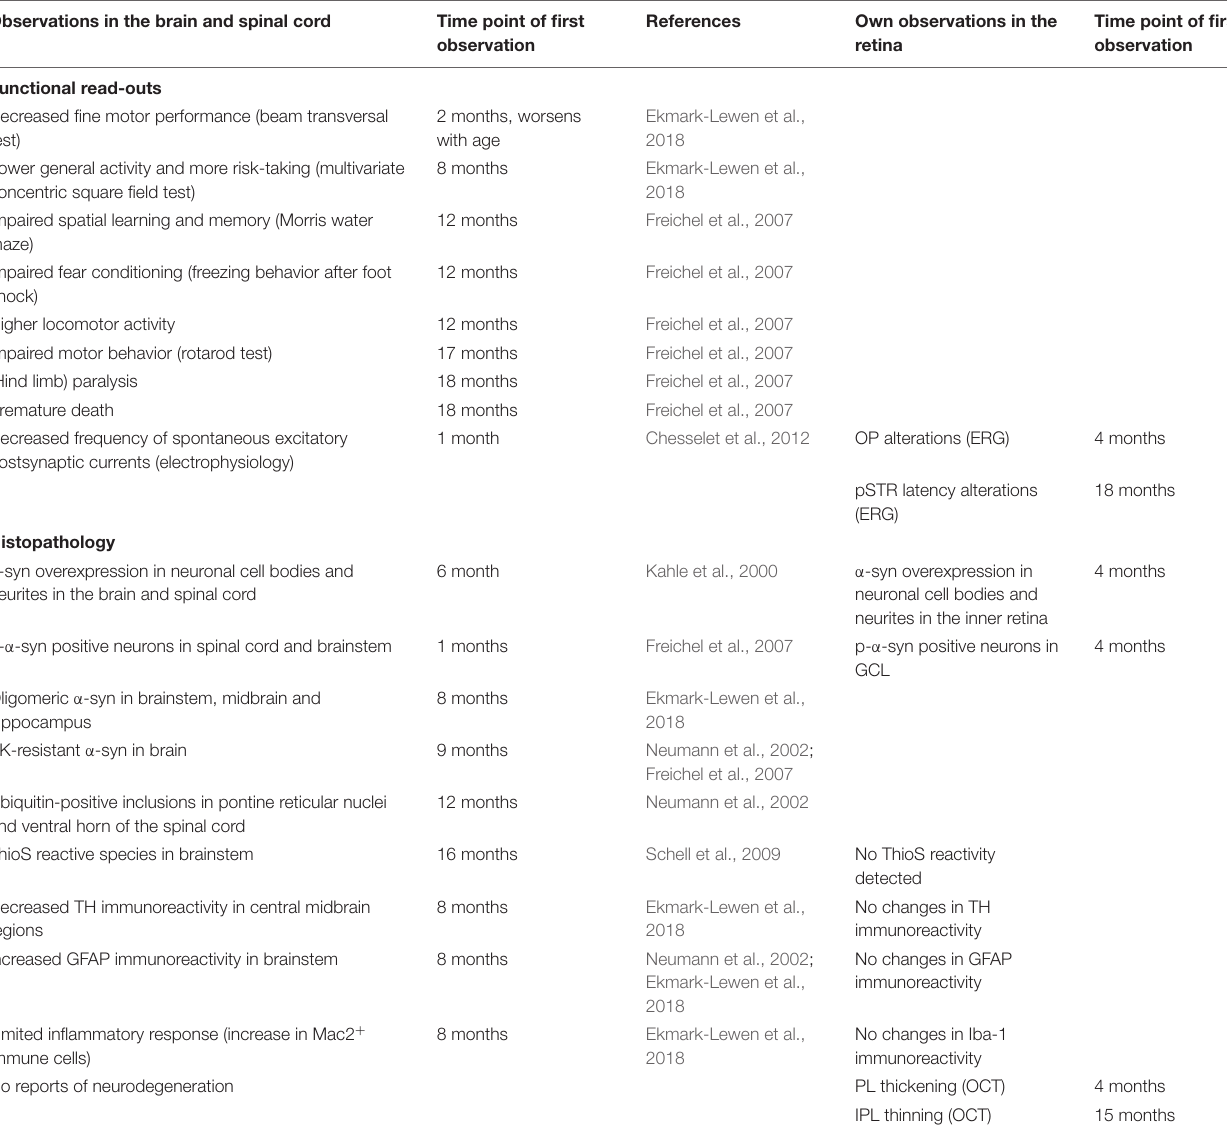
TABLE 2 | Overview of the reported phenotypical alterations in the brain and spinal cord of Thy1-h[A30P] α -syn mice, in relation to observations in the